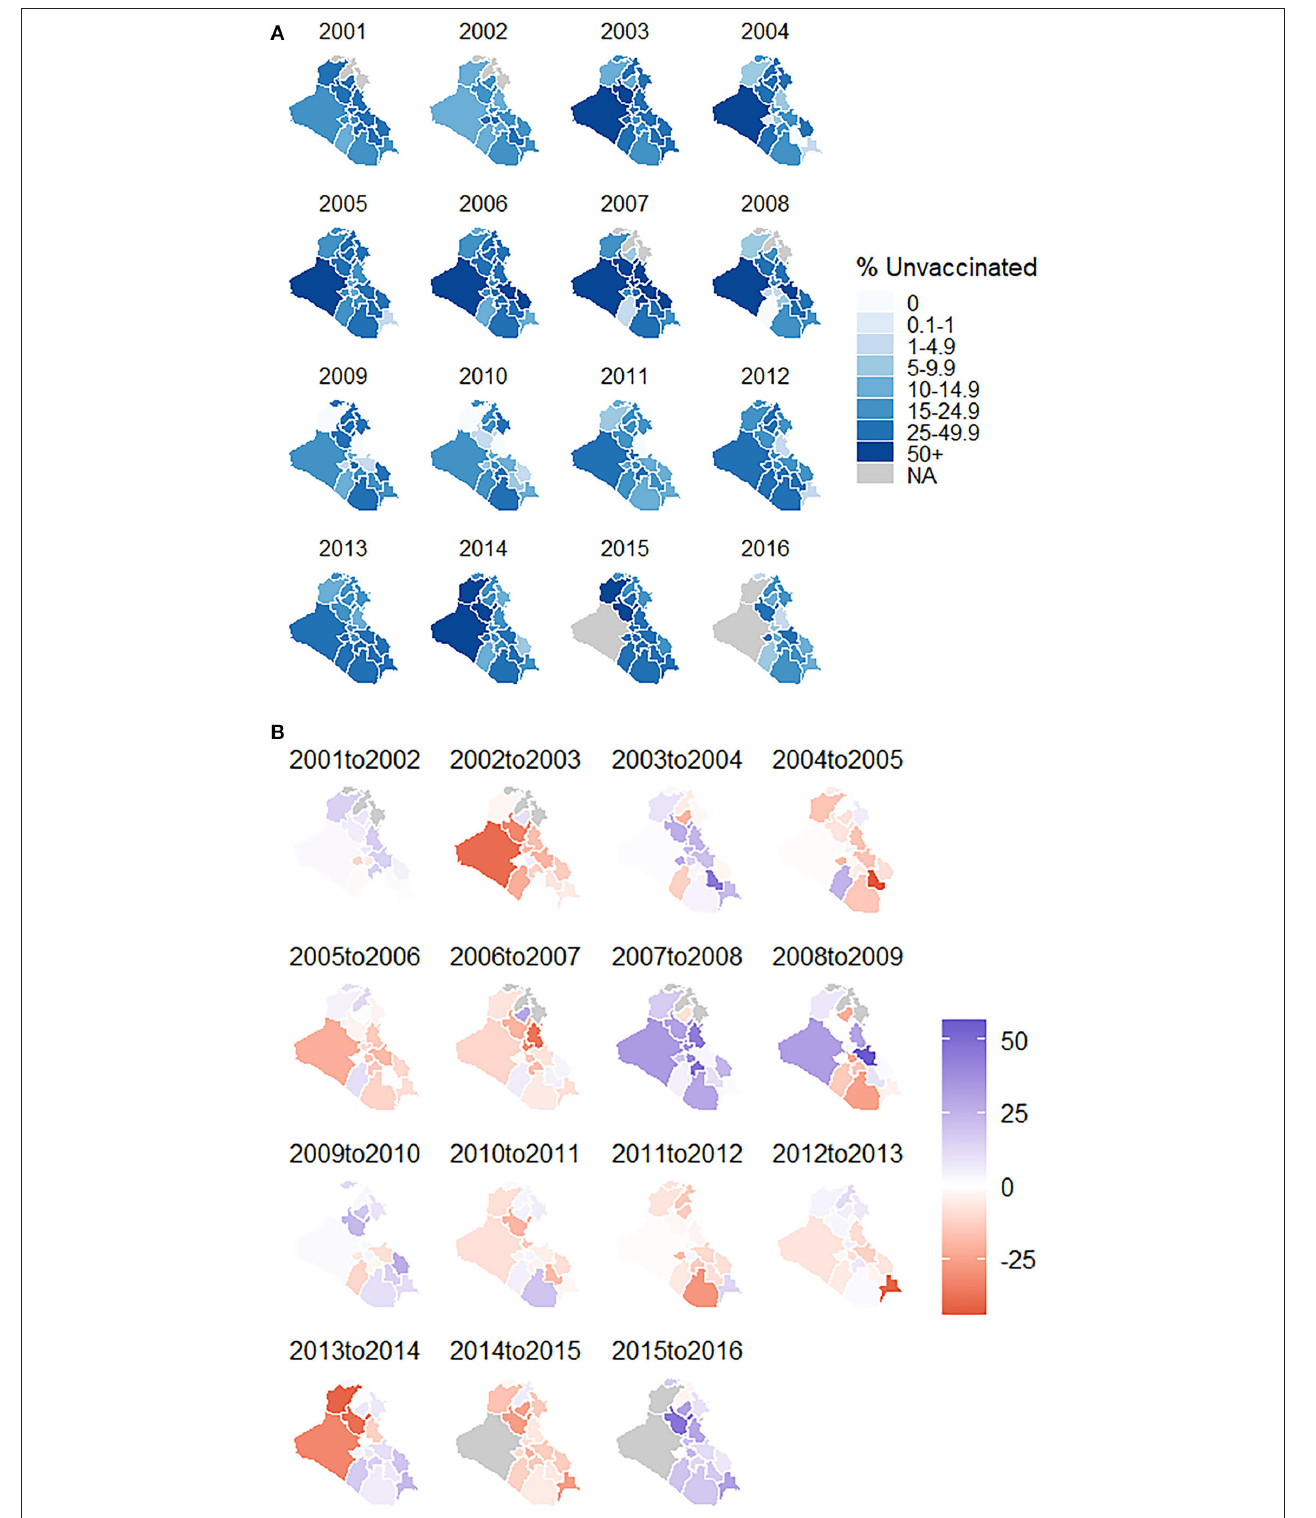
FIGURE 2 | (A) MMR vaccine coverage in Iraq by governorate, 2001–2016 (B) absolute change in MMR vaccine coverage from previous year in Iraq by governorate, 2001–2016.